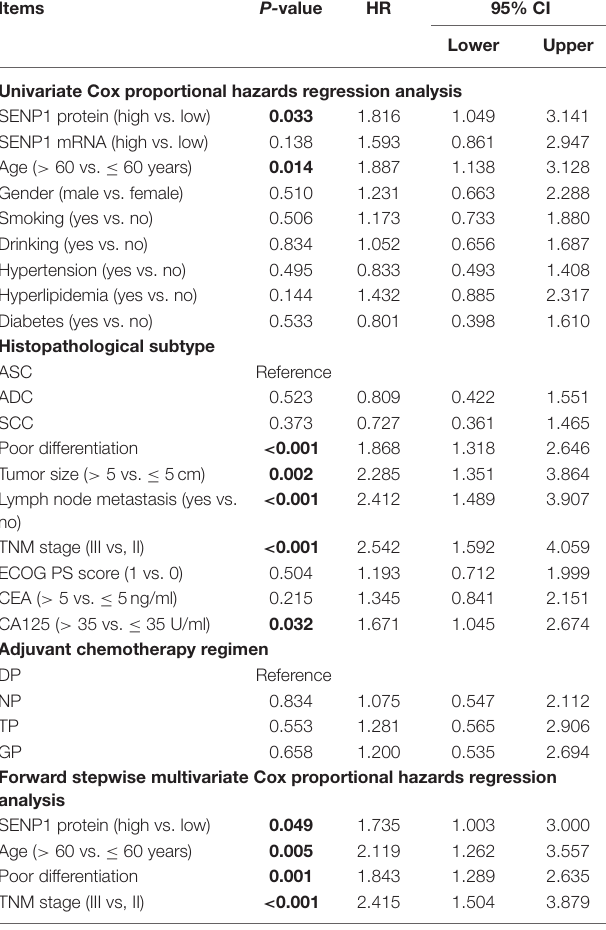
FIGURE 4 | Comparison of accumulating OS between patients with surgical NSCLC with different SENP1 expressions. Comparison of accumulating OS between patients with surgical NSCLC with SENP1 protein high and SENP1 protein low (A) and comparison of accumulating OS between patients with surgical NSCLC with SENP1 mRNA high and SENP1 mRNA low (B) . SENP1, small ubiquitin-like modifier (SUMO)-specific protease 1; OS, overall survival; NSCLC, non-small cell lung cancer. TABLE 4 | The Cox proportional hazards regression analysis for